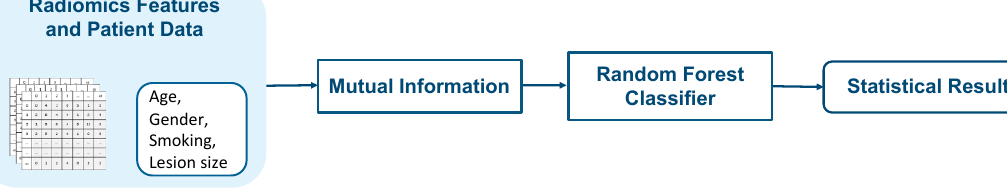
Figure 6. Block diagram of the radiomics feature and patient data-based model.